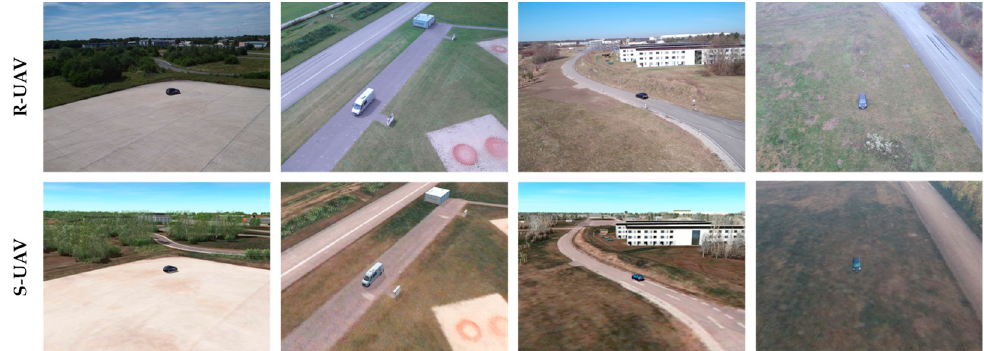
Figure 7. Comparison between real sensor images (R-UAV) and the corresponding synthetic duplicates (S-UAV) for the four acquisition positions.